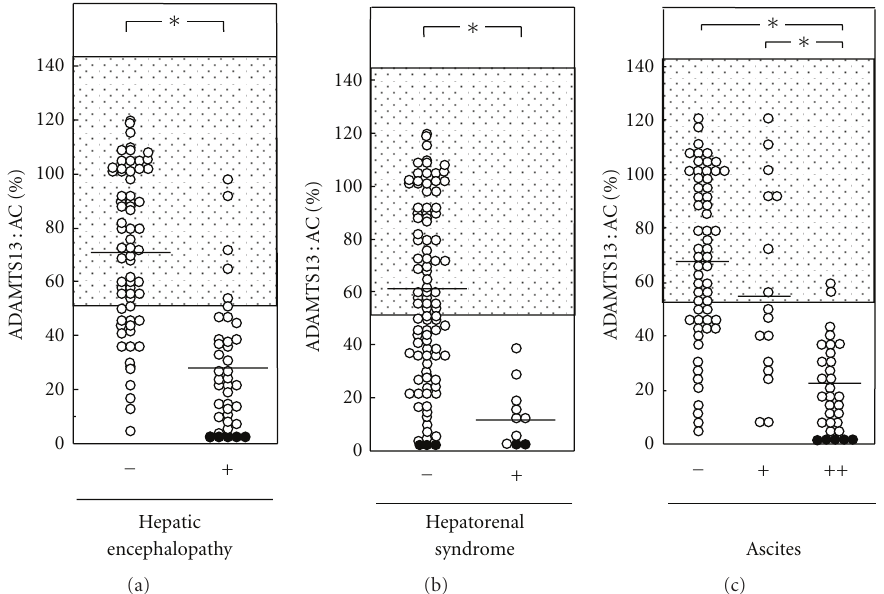
Figure 3: Relationship of ADAMTS13:AC to the presence or absence of hepatic encephalopathy, hepatorenal syndrome, and ascites in patients with liver cirrhosis. The ADAMTS13:AC was significantly lower in LC patients with hepatic encephalopathy (a) and hepatorenal syndrome (b) than that those without. Moreover, patients with refractory ascites had lower ADAMTS13: AC than those without ascites or those with easily mobilized ascites (c). Closed circles indicate patients whose plasma ADAMTS13:AC was extremely low ( < 3% of normal control by VWFM assay). ADAMTS13: AC:ADAMTS13 activity; ∗ P < . 001 significantly di ff erent between the two groups. (Partially modified from Uemura et al., [30]).